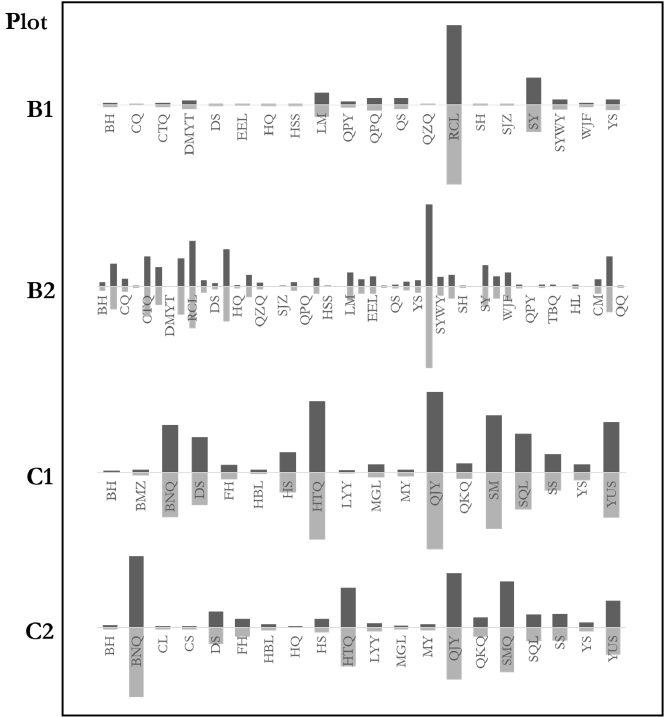
Figure 7. Abundance distributions of stands and random trees. Distributions of the stands are above the horizontal axes. Distributions of the random trees are below the horizontal axes. Species of C2 are not all listed to save space. BH, Betula platyphylla Suk.; CQ, Kalopanax septemlobus (Thunb.) Koidz.; CTQ, Acer ginnala Maxim.; DMYT, Cerasus polytricha; DS, Tilia mongolica Maxim.; EEL, Carpinus turczaninowii Hance; HQ, Sorbus pohuashanensis (Hance) Hedl.; HSS, Pinus armandii Franch.; LM, Swida macrophylla (Wall.); QPY, Acer cappadocicum Gled.; QPQ, Populus cathayana var. cathayana ; QS, Toxicodendron vernicifluum (Stokes) F.A. Barkley; QZQ, Acer davidii Franch.; RCL, Quercus aliena